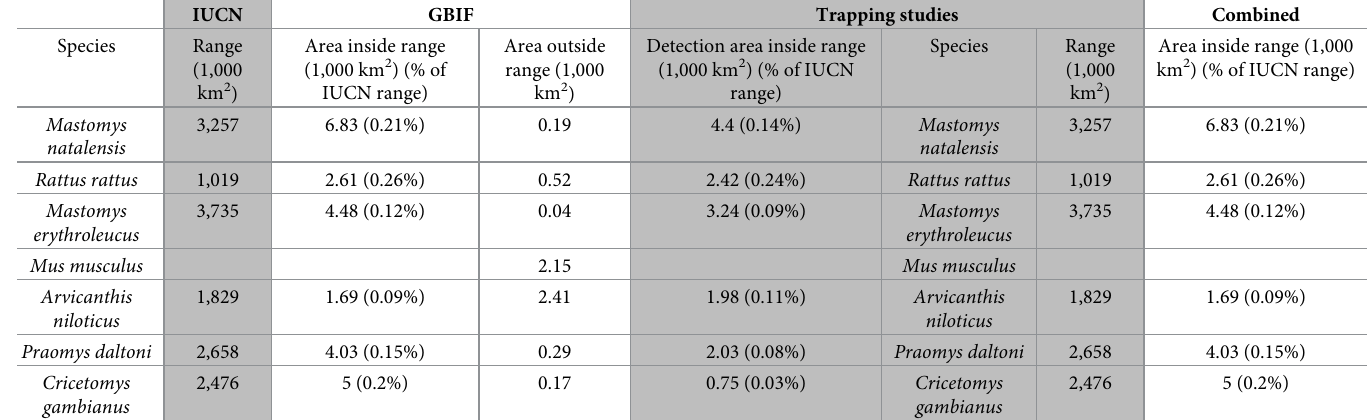
Table 1. Comparison of IUCN, GBIF and rodent trapping ranges for the 7 most detected rodent